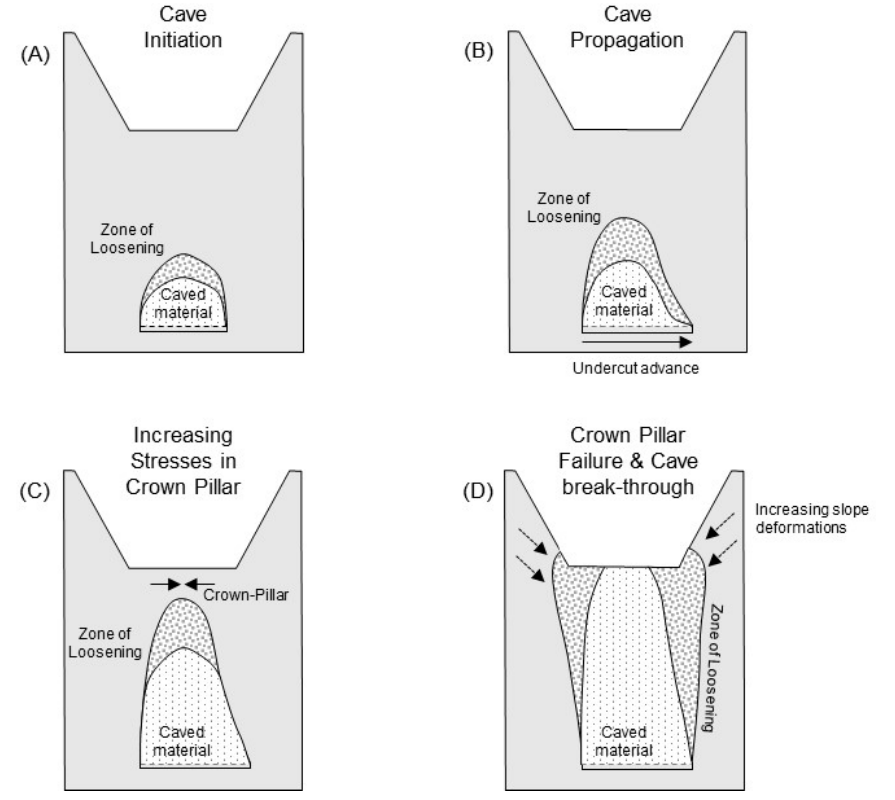
Figure 9. Different stages of the pit-to-cave transition. ( A – D ) refers to progressive stages of cave development and induced slope deformations.